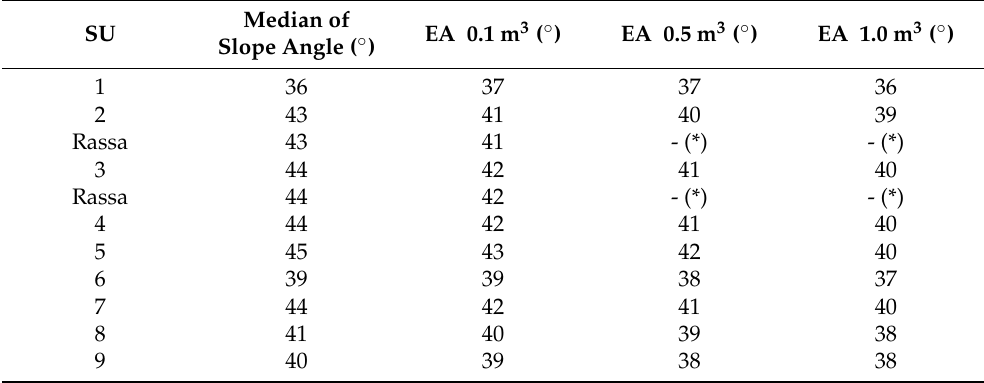
Table 1. Median slope value for each slope unit and energy angle according to [20]. (*) data indicated with “-” are not computed as in that area the only block volume is 0.1 m 3